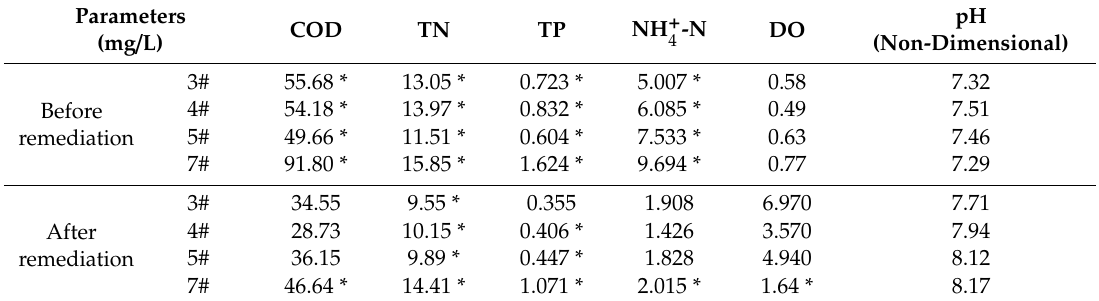
Table 2. Physicochemical parameters of the overlying water before and after